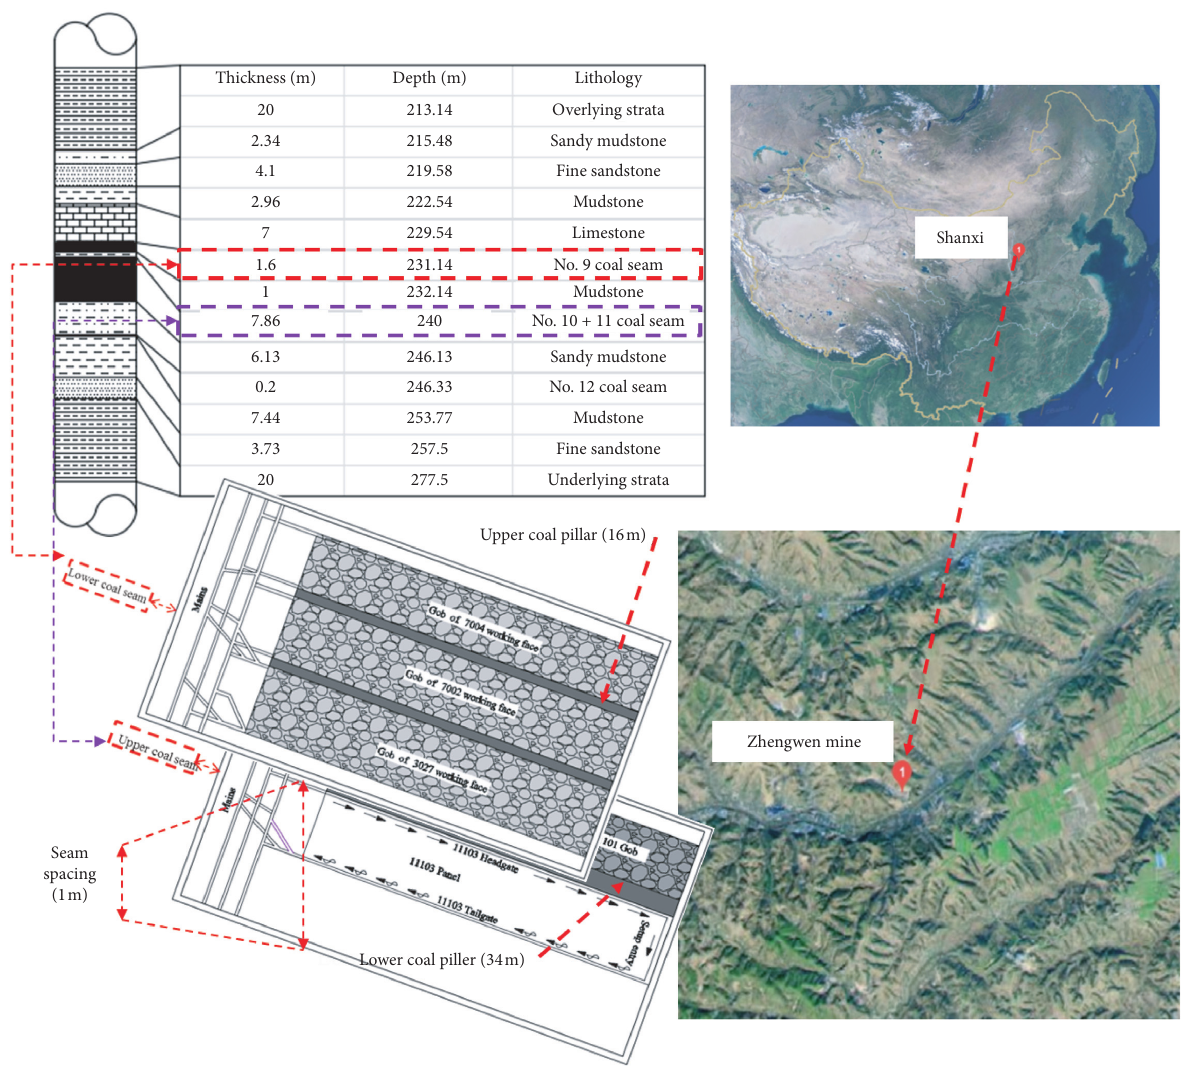
Figure 2: Distribution and excavation under double gobs in close coal